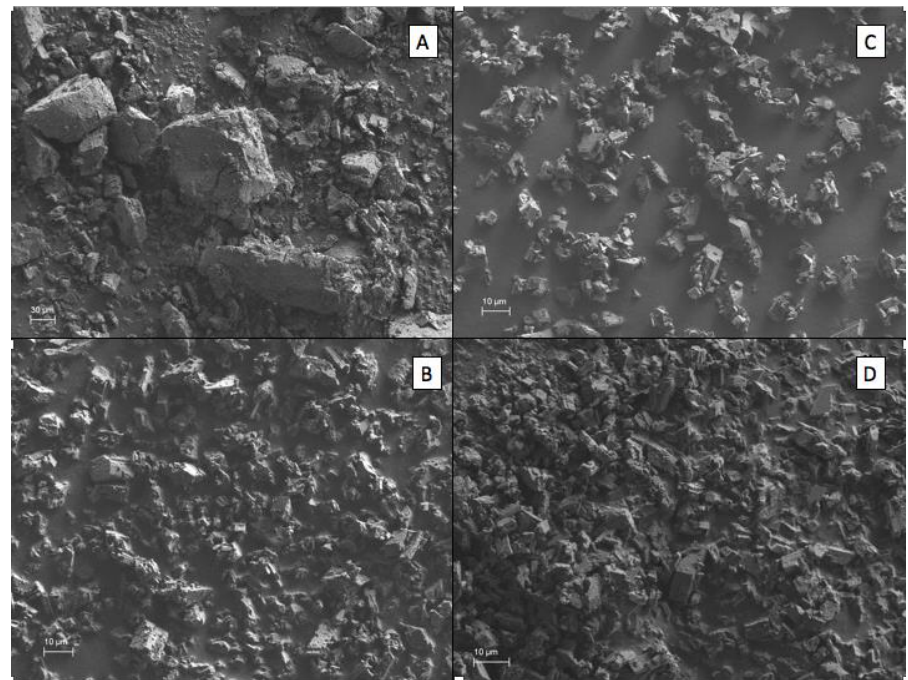
Figure 2. Surface morphologies of the 12:88 ratio compared with pure β–CD as a control. ( A ) Pure β–CD, ( B ) 5x-β–CD, ( C ) 10x-β–CD, ( D ) 20x-β–CD.